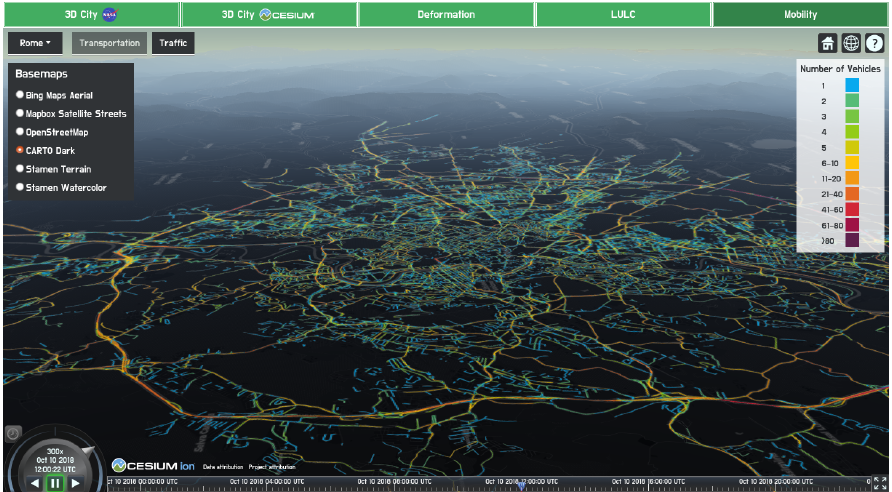
Figure 14. Visualization of traffic in Rome between 12:00 and 13:00 UTC on a virtual globe created using